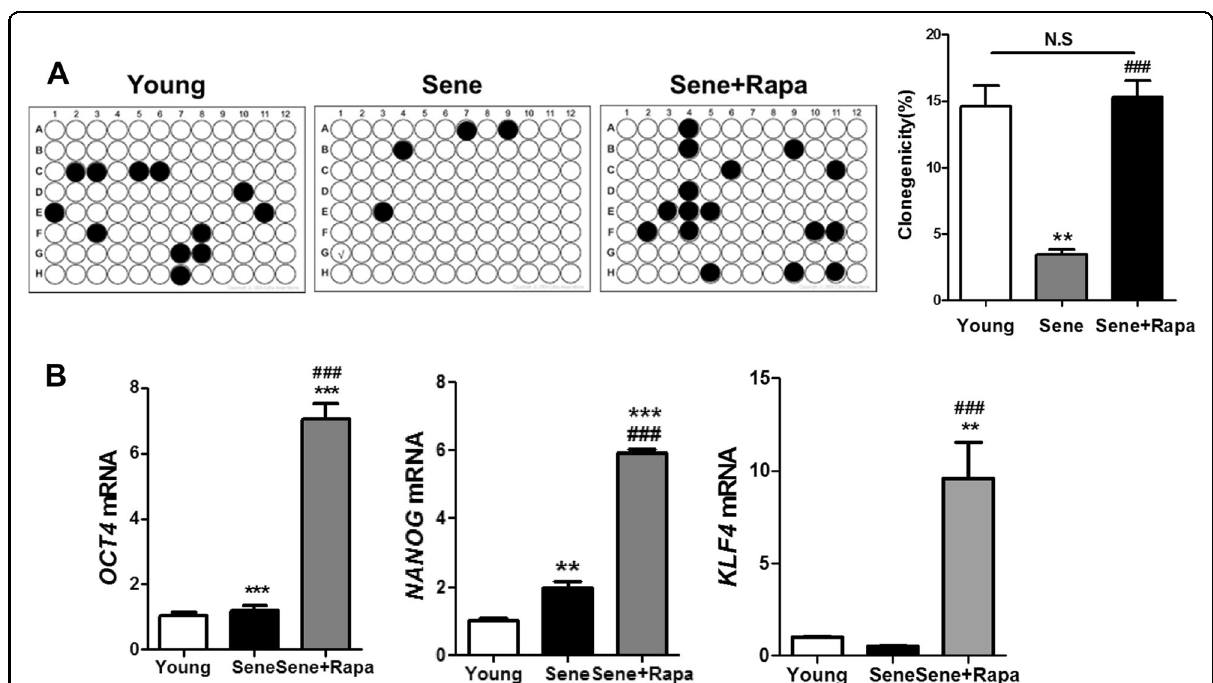
Fig. 3 The effect of rapamycin on the clonogenic potential of senescent CPCs. a Clonogenic ability in senescent hCPCs after prolonged rapamycin treatment. The graph represents the percentage of wells that maintained clones for 14 days (** p ≤ 0.01, vs. young, ### p ≤ 0.001, vs. senescent). b The expression of the clonogenicity markers (OCT4, KLF4, and NANOG) was examined in senescent hCPCs after prolonged rapamycin treatment via qRT-PCR (* p ≤ 0.05). Error bars indicate